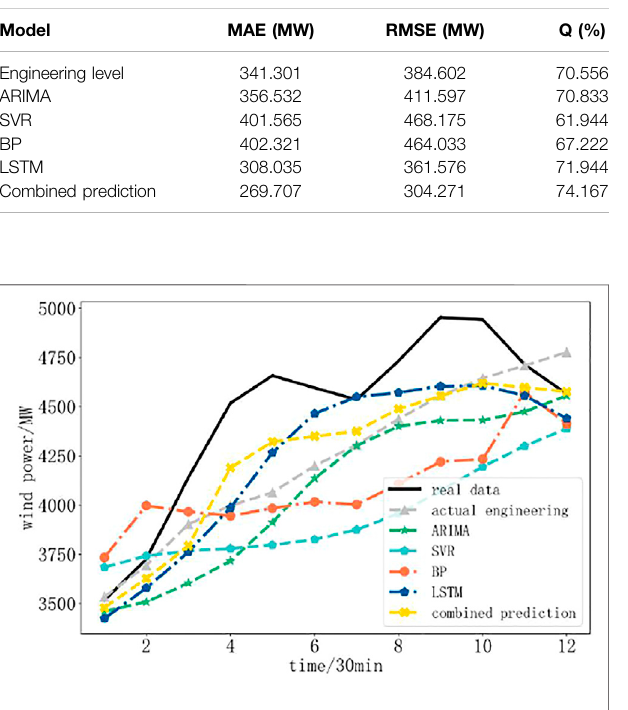
FIGURE 8 | Comparison of prediction results.